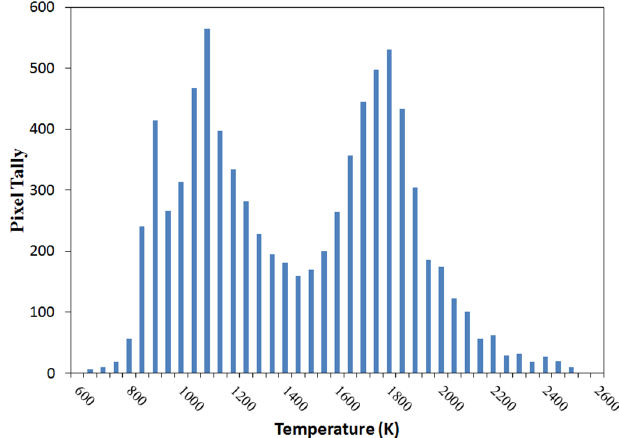
Figure 3. Temperature histogram for a single day of VIIRS Nightfire (VNF) data. The distribution is bimodal, with the majority of gas flares falling in the range from 1500 K to 2000 K. Biomass burning, industrial sites and volcanoes have temperatures in the 600–1300 K range. The range from 1300 K to 1500 K is a crossover zone between gas flares and biomass burning.